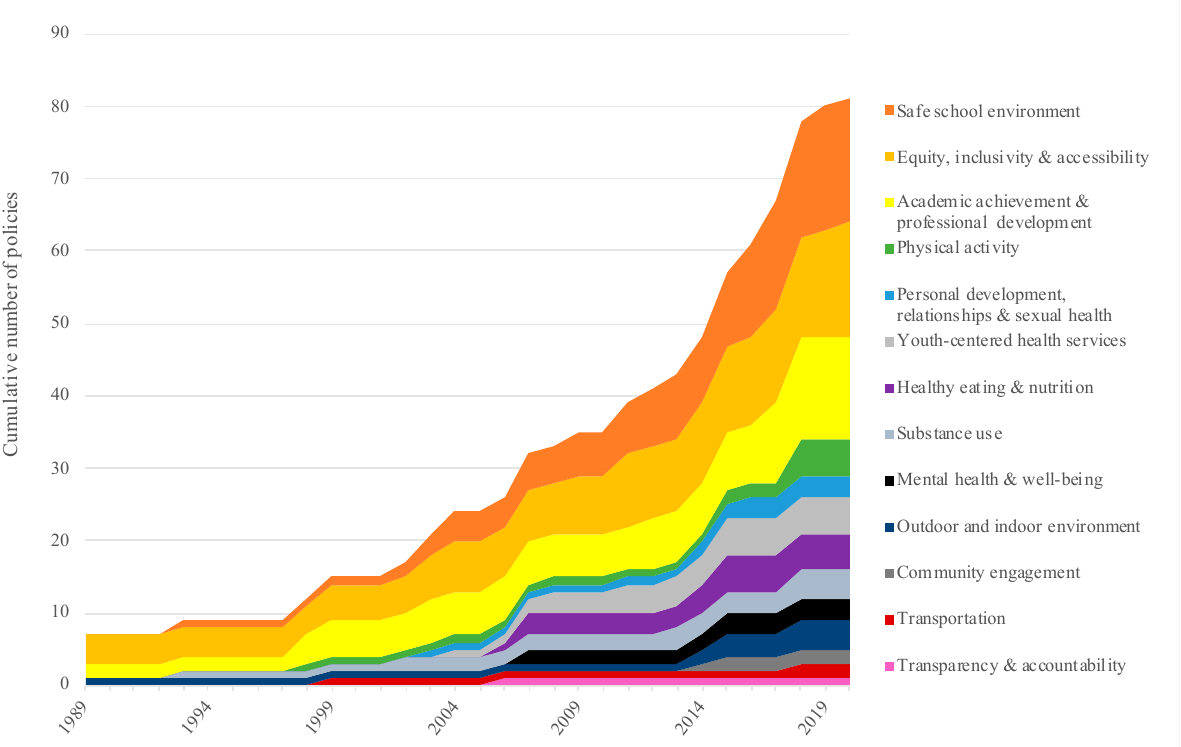
Figure 2. Growth in Nova Scotia Provincial-level Policies According to Health Promotion Topic: 1989–2020. Growth in the number of Nova Scotia provincial-level policies over time was examined according to the initial policy implementation date, allowing for improved understanding of which health promotion topics accrued new policies at higher or lower rates during this